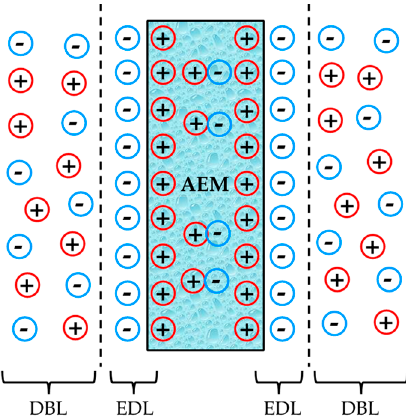
Figure 1. Anion exchange membrane diagram including both electric double-layer (EDL) and diffusion boundary layer (DBL) effects, adapted with permission from [40]. Copyright 2016 Elsevier.